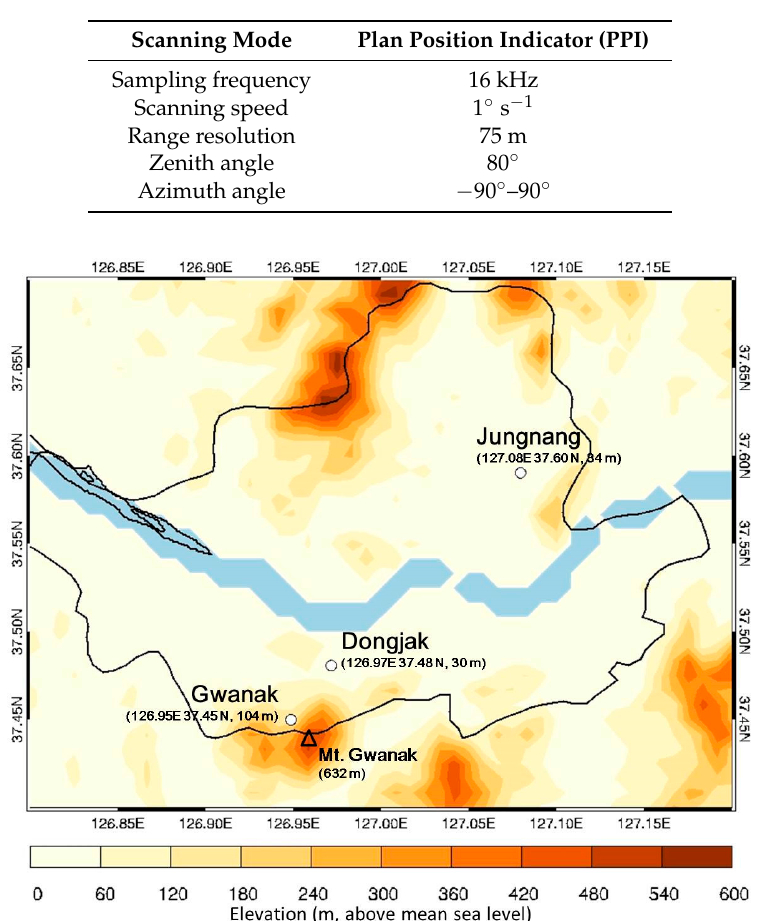
Figure 1. Geological location of the Gwanak, Jungnang, and Dongjak sites, and topography of the Seoul metropolitan area.